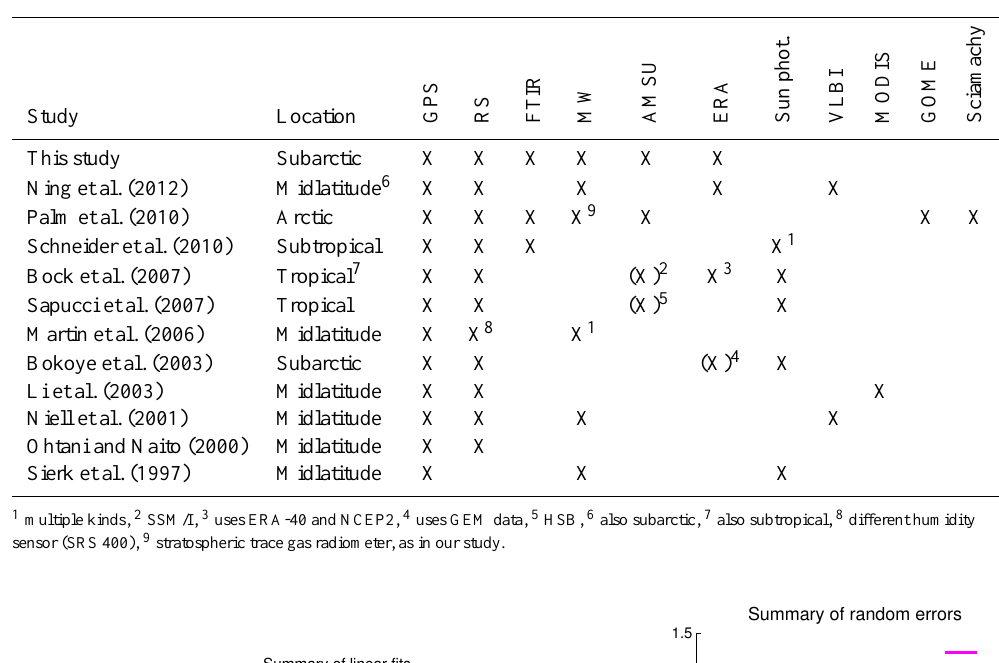
Table 5. An overview of other published IWV comparison studies that include at least two of our datasets. Note that, with the exception of the Palm et al. study, MW for the other studies typically implies a dual channel microwave radiometer designed for IWV and LWP measurements, not an ozone radiometer as in our study.